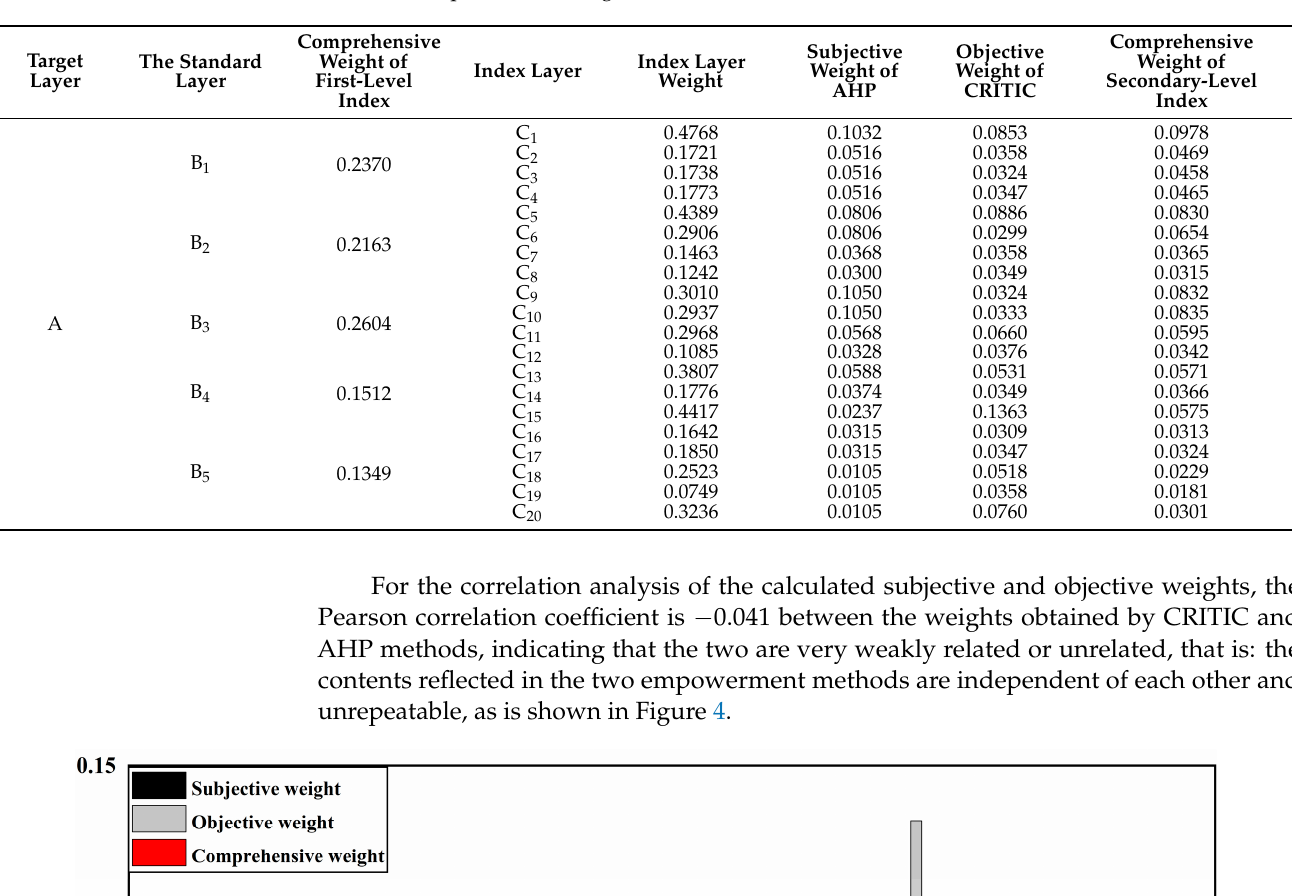
Table 5. Comprehensive weight calculation results of evaluation indicators.